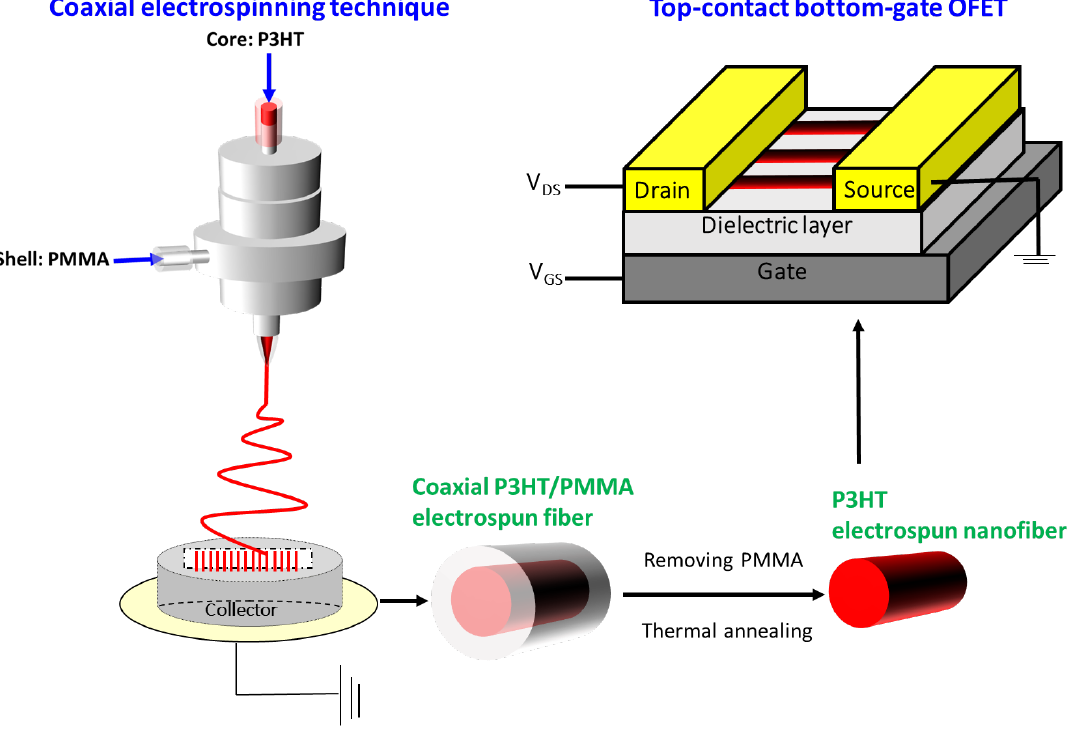
Figure 1. Schematic of the coaxial electrospinning setup and poly(3-hexylthiophene-2,5-diyl) (P3HT) electrospun nanofiber-based organic field-effect transistors (OFETs). Abbreviations: PMMA, poly(methyl methacrylate).